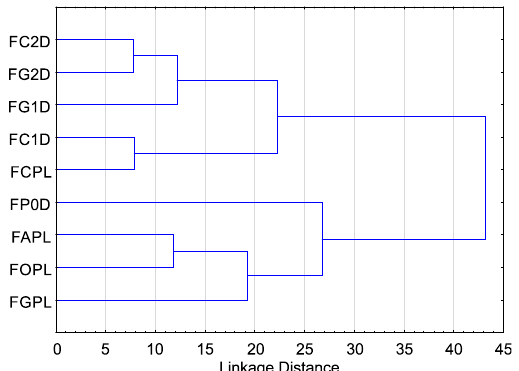
Figure 3. Variability of sensitivity of Fusarium spp. isolates—ordered after cluster analysis (D-Germany, PL-Poland.): FC2D— F. culmorum , FG2D— F. graminearum , FG1D— F. graminearum , FC1D— F. culmorum , FCPL— F. culmorum , FP0D— F. poae , FAPL— F. avenaceum , FOPL— F. oxysporum , FGPL— F. graminearum .